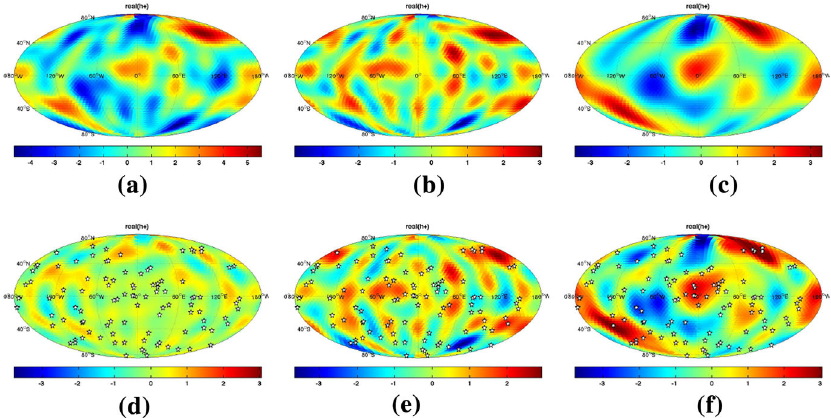
Fig. 55 Mollweide projections of the real parts of h + ( ˆ n ) for the different components of the simulated background (panels a – c ), the maximum-likelihood recovered map for a pulsar timing array consisting of N = 100 pulsars (panel e ), and the corresponding residual maps for the grad-component (panel d ) and the total simulated background (panel f ). Sky maps of the imaginary part of h + ( ˆ n ) and the real and imaginary parts of h × ( ˆ n ) are similar, and hence are not shown in this figure. Note that the maximum-likelihood recovered map most-closely resembles the gradient component of the simulated background, since a pulsar timing array is insensitive to the curl modes of a gravitational-wave background. Image reproduced with permission from Gair et al. (2014), copyright by APS. a Total map (grad+curl). b Gradient component. c Curl component. d Gradient residual map. e Max-likelihood recovered map. f Total residual